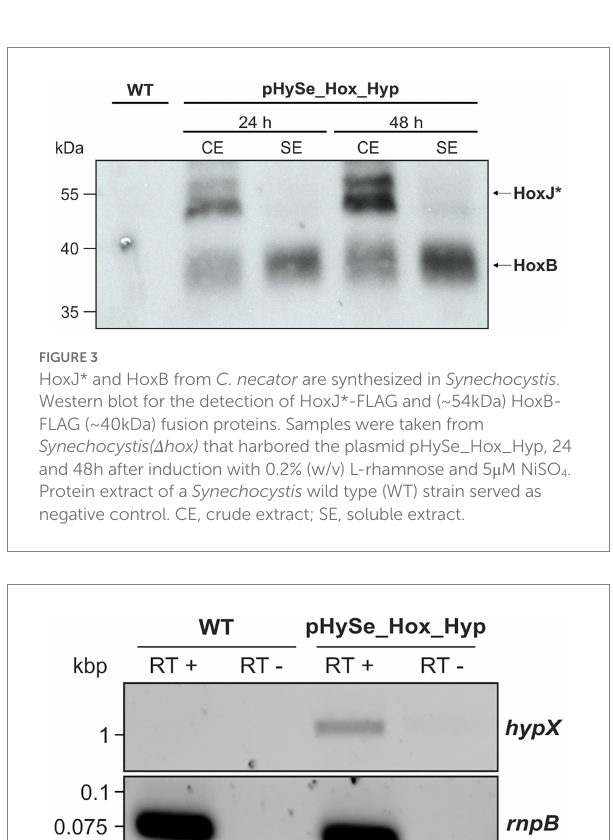
FIGURE 4 The polycistronic hyp mRNA is being transcribed in Synechocystis . PCR amplification of hypX or the housekeeping gene rnpB from cDNA that has been prepared from RNA isolates of Synechocystis wild type (control) or a strain harboring pHySe_Hox_Hyp. Samples in lanes denoted ‘RT +’ were treated with reverse transcriptase beforehand, while those indicated ‘RT − ’ were